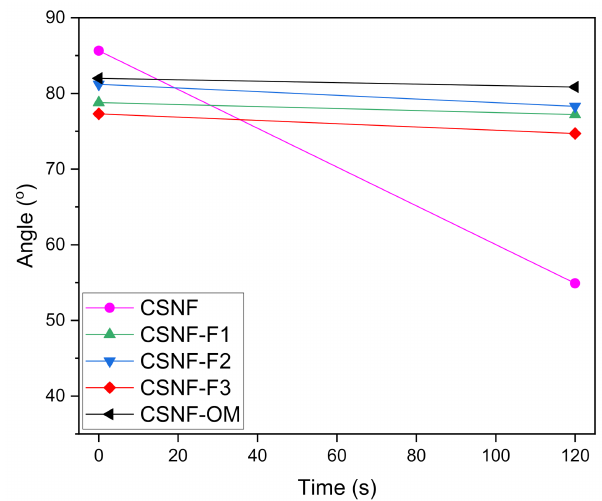
Figure 4. The water contact angle of nanocomposite